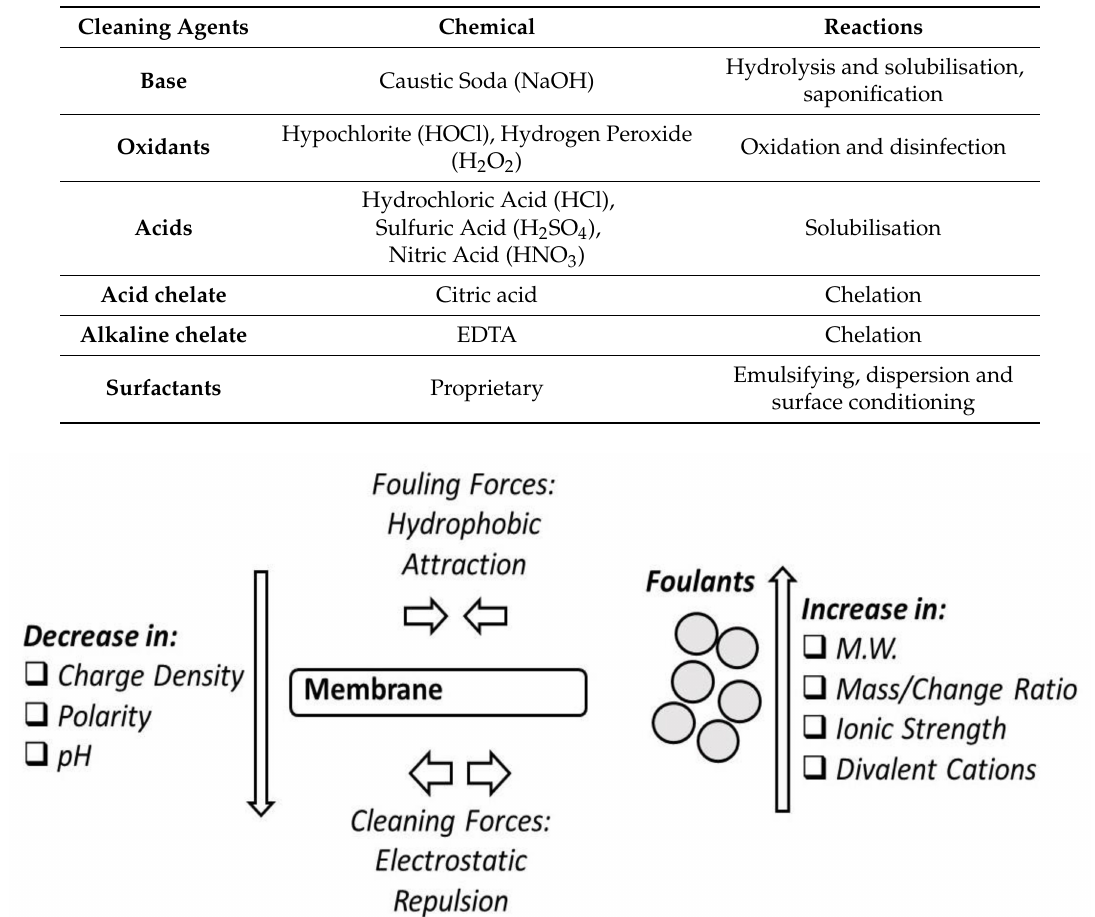
Figure 8. Schematic stage model for solution transport